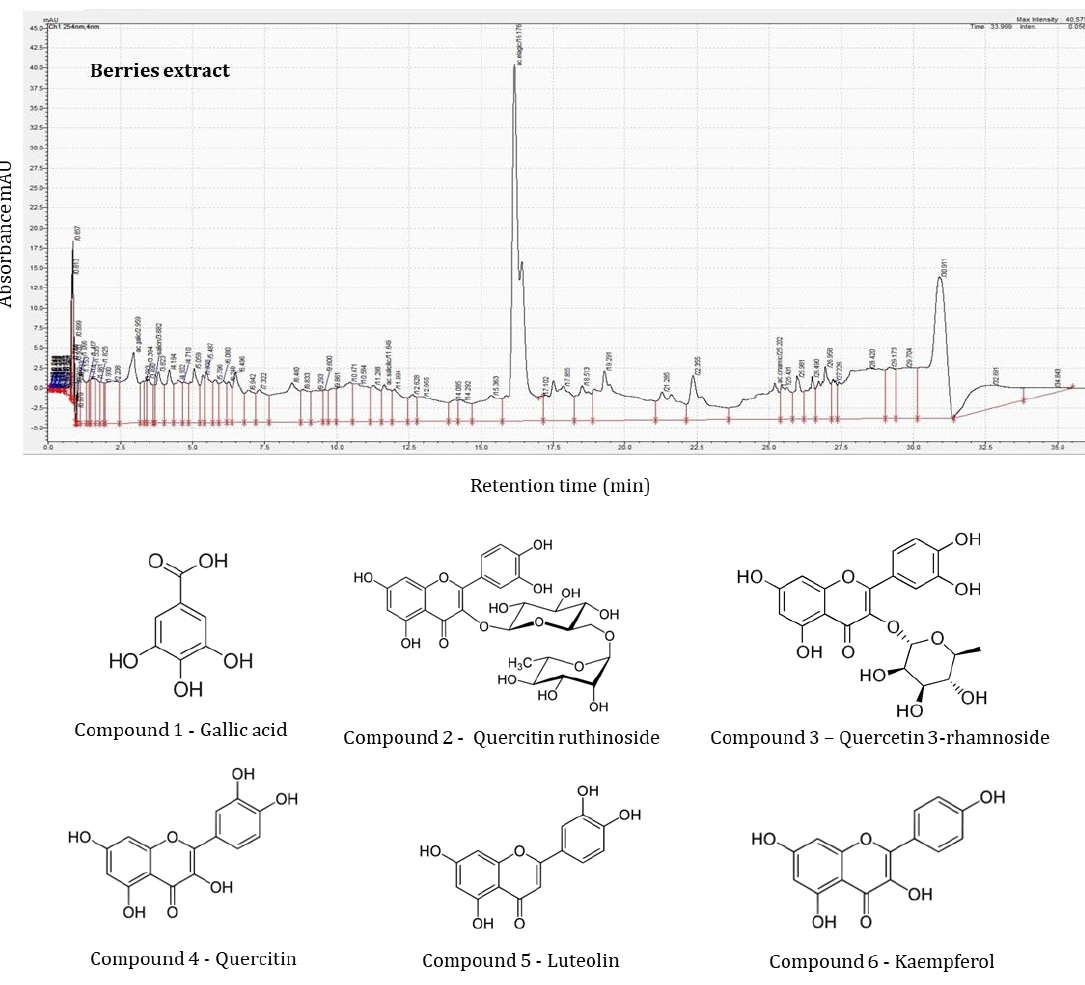
Figure 2. HPLC profile of sea buckthorn berry extracts.